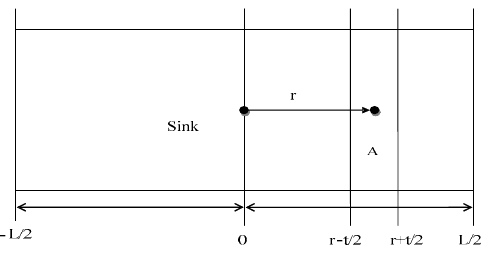
Figure 3. The network area diagram for analyzing energy consumption.